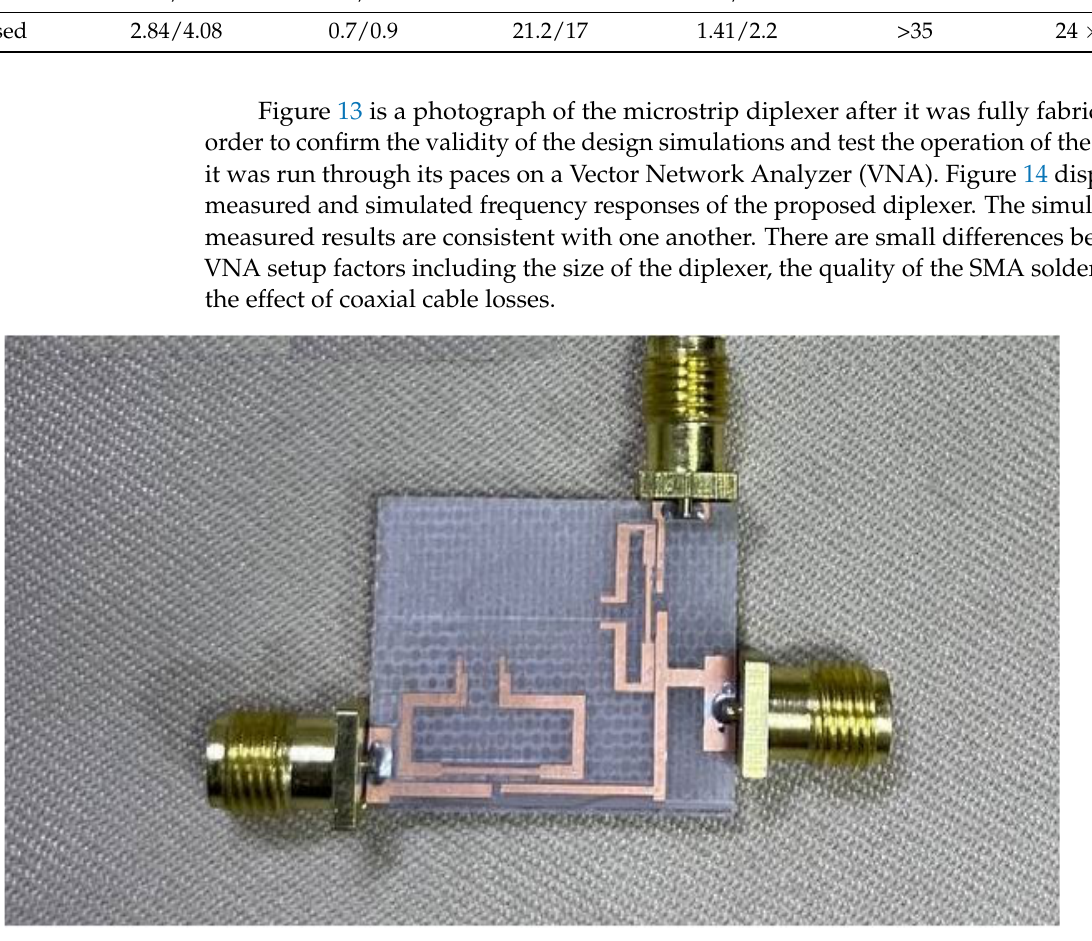
Figure 13. Fabricated diplexer prototype.